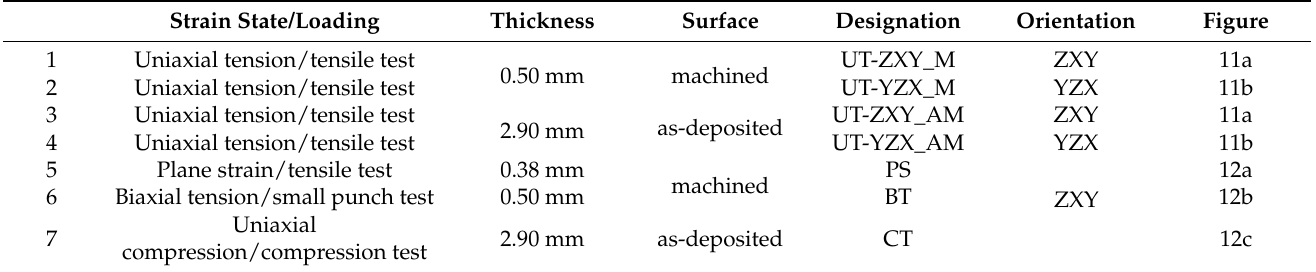
Table 2. Mechanical testing—sample portfolio including loading mode, surface state and thickness, orientation and designation of the